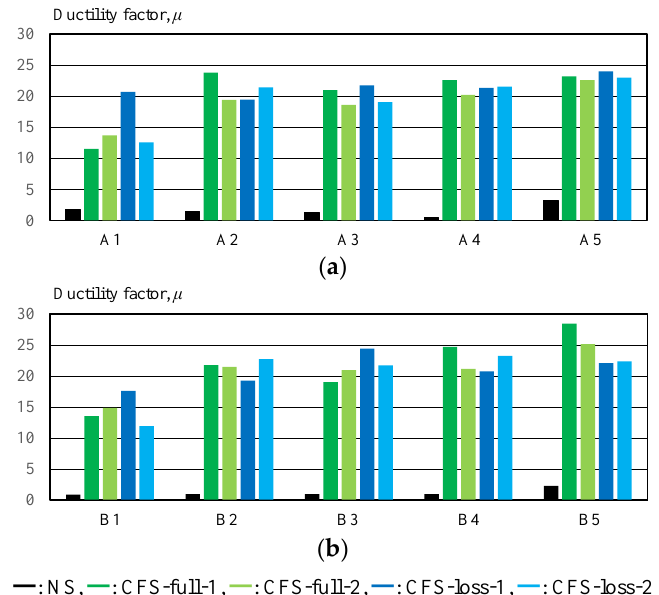
Figure 16. Ductility factor as evaluated through experiment: (a) gauge position A1 ~ A5; (b) gauge position B1 ~ B5.